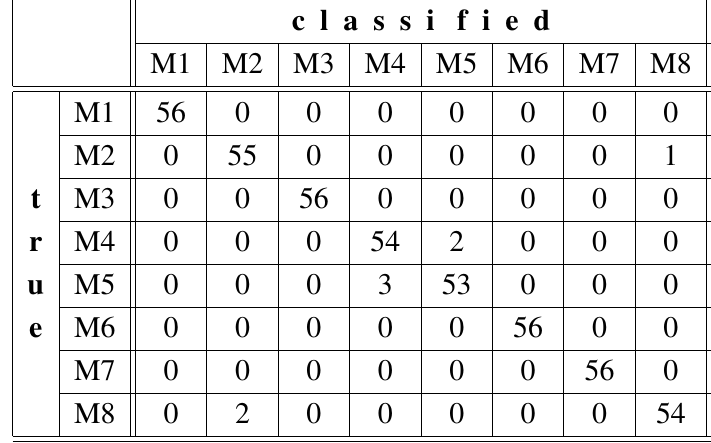
Table 6. Confusion matrix for BDM (LOO cross validation, 98.2%).